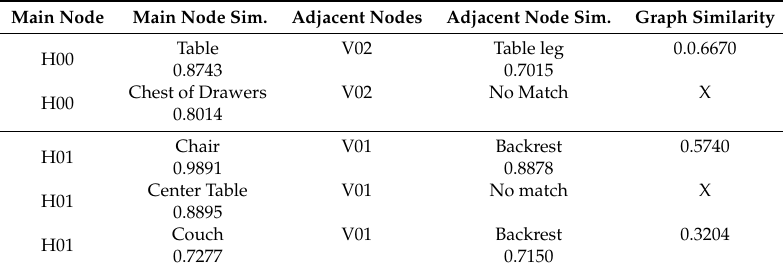
Table 4. Example for graph classification. Main Node Main Node Sim. Adjacent Nodes Adjacent Node Sim. Graph